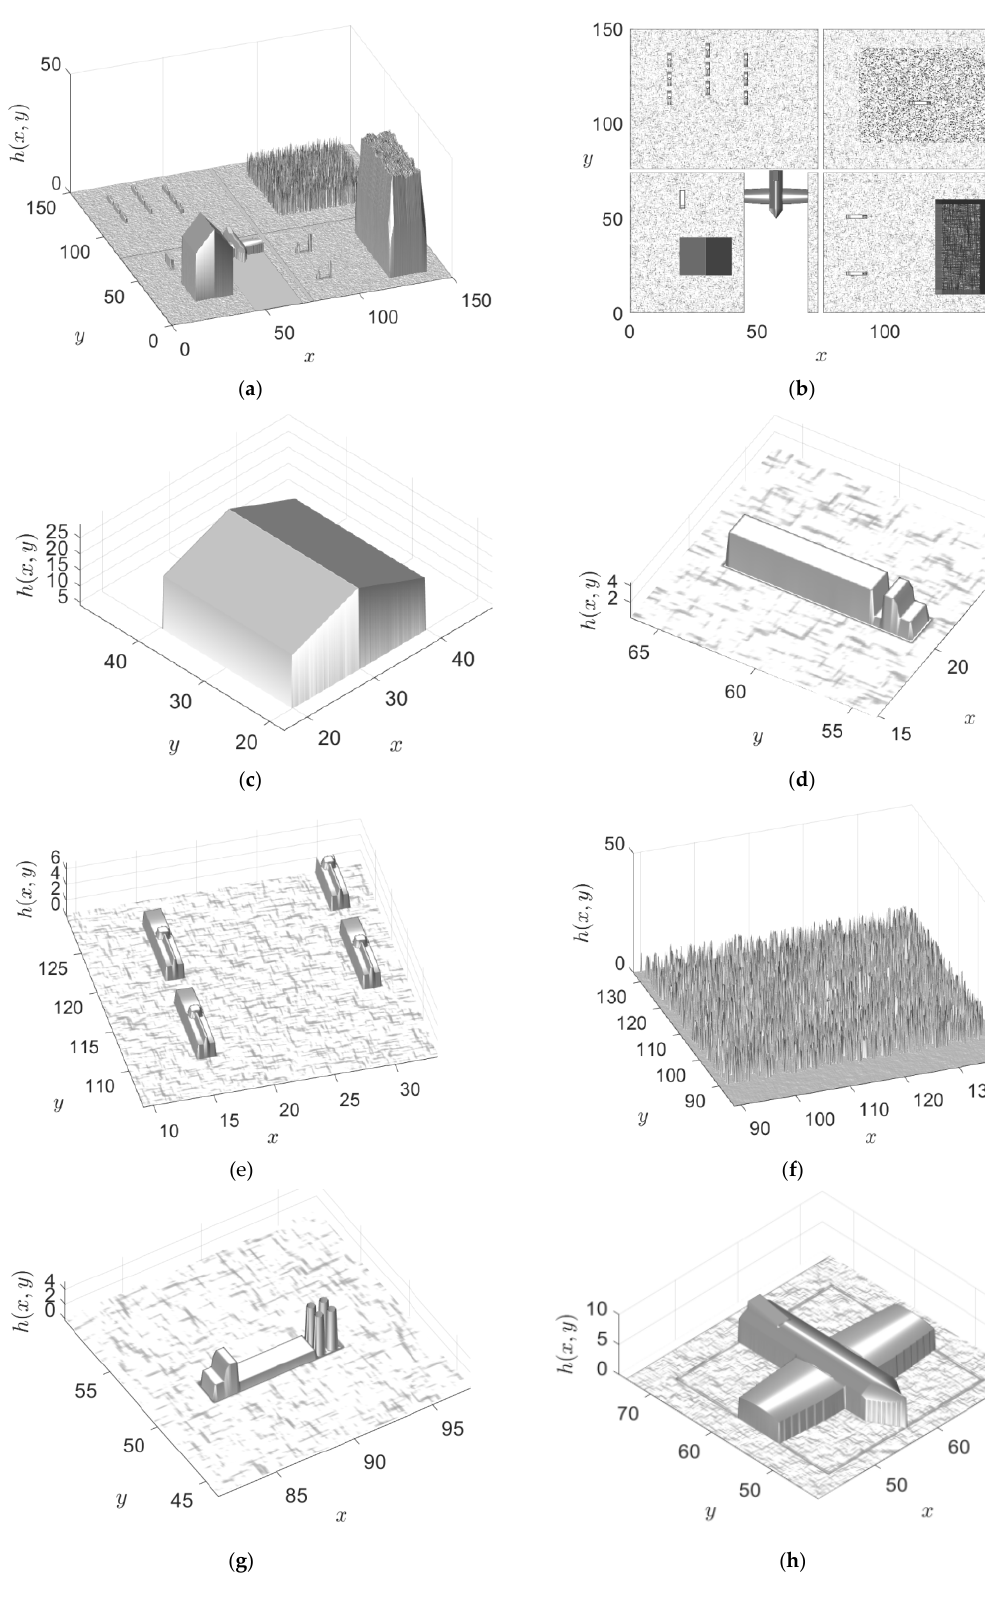
( b ) ( c ) Figure 4. Characteristics of the test surface: ( a ) the radar cross section, ( b ) the real part of the complex scattering coefficient, ( c ) the top projection of  Re{F(x,y)} .